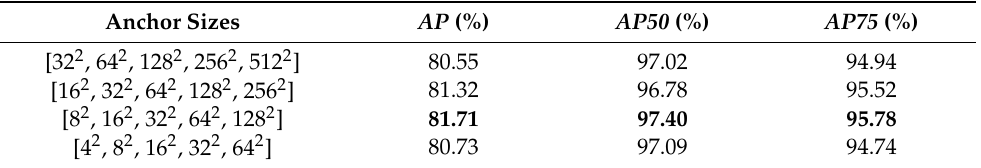
Table 5. Analysis of different anchor sizes on the UED dataset.